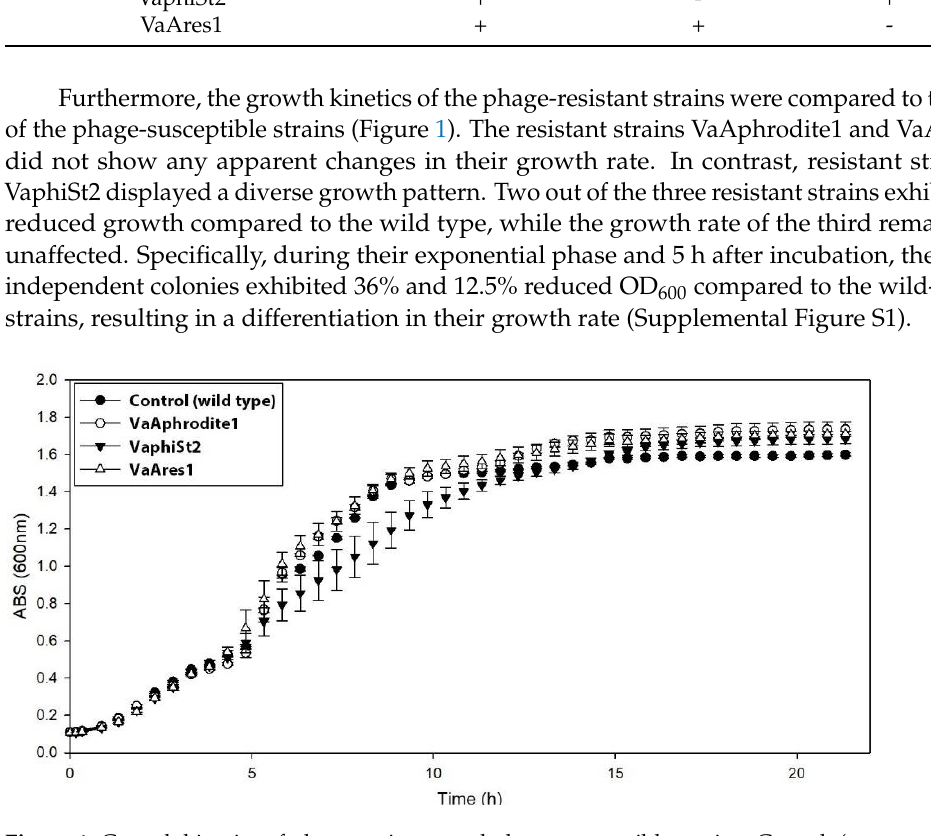
Figure 1. Growth kinetics of phage-resistant and phage-susceptible strains. Growth (average, ±SE) of the Control (phage-susceptible strains; black circle; n = 3), VaAphrodite1 strains (phage strains resistant to bacteriophage Aphrodite1; white circle; n = 9), VaphiSt2 strains (phage strains resistant to bacteriophage phiSt2; black triangle; n = 9), and VaAres1 strains (phage strains resistant to bacteriophage Ares1; white triangle; n = 9).